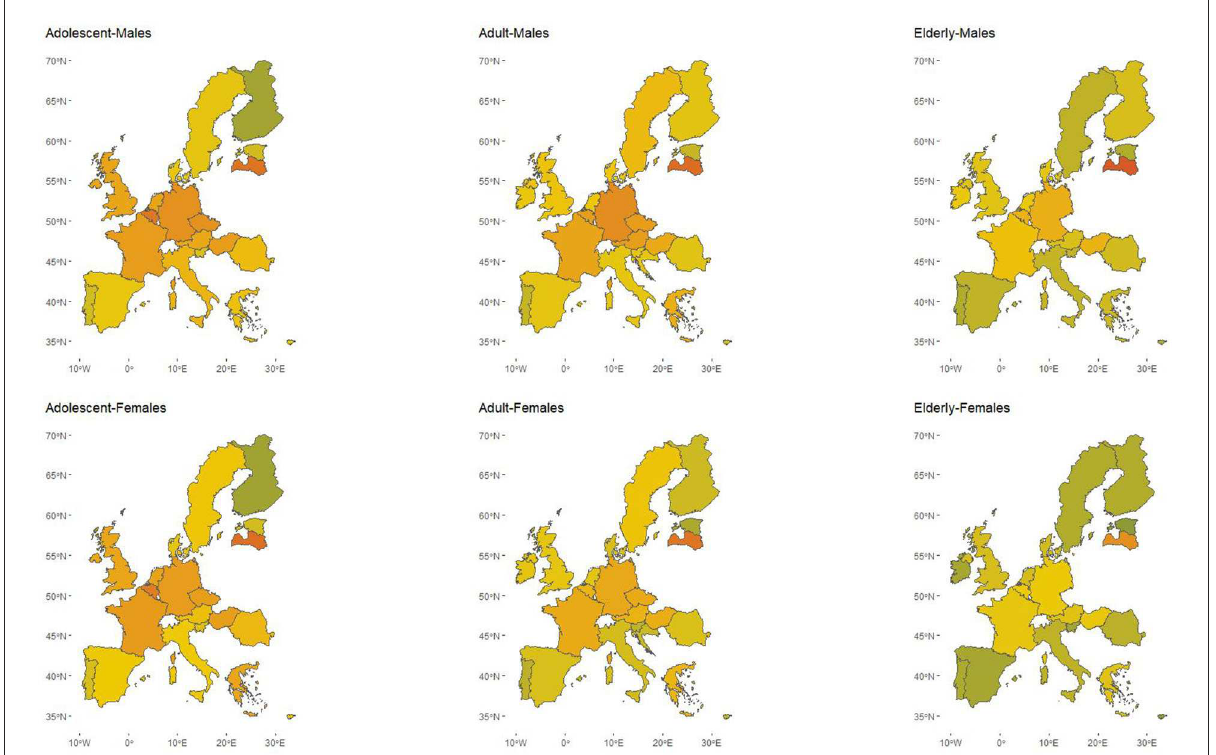
FIGURE2 Nutritional value of diets across European populations summarized according to the Food Standard Agency modified Nutrient Profiling System Dietary Index (FSAm-NPS-DI) 1 , stratified by age-group and